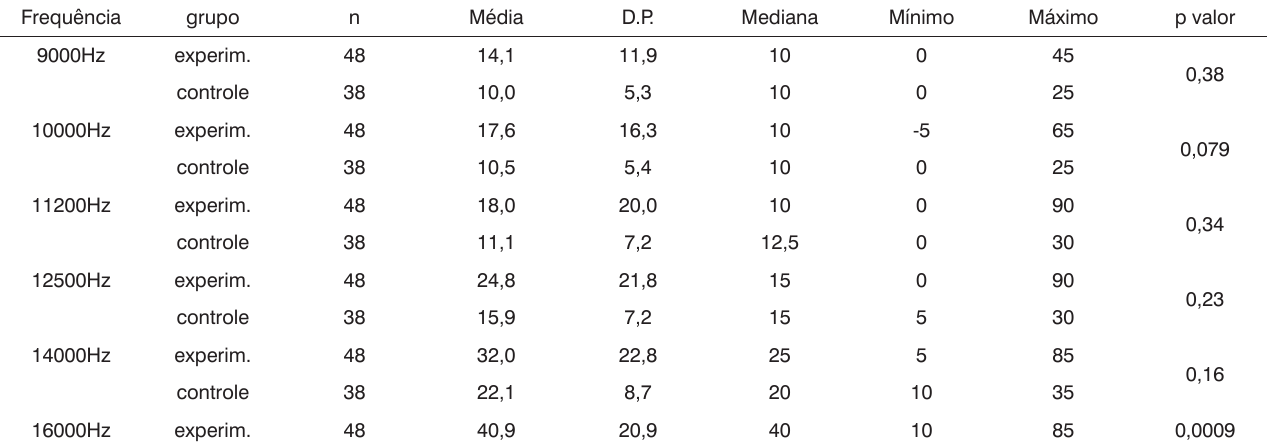
Tabela 2. Análise estatística dos limiares no total das orelhas segundo os subgrupos 1 e 3 na faixa de 30 a 39 anos.